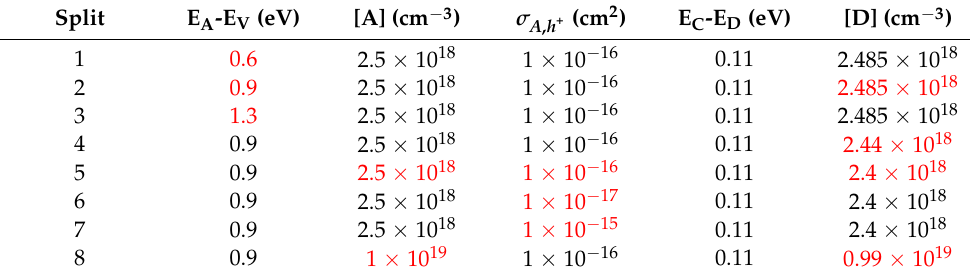
Table 2. TCAD simulation split table (with changed parameter in red).